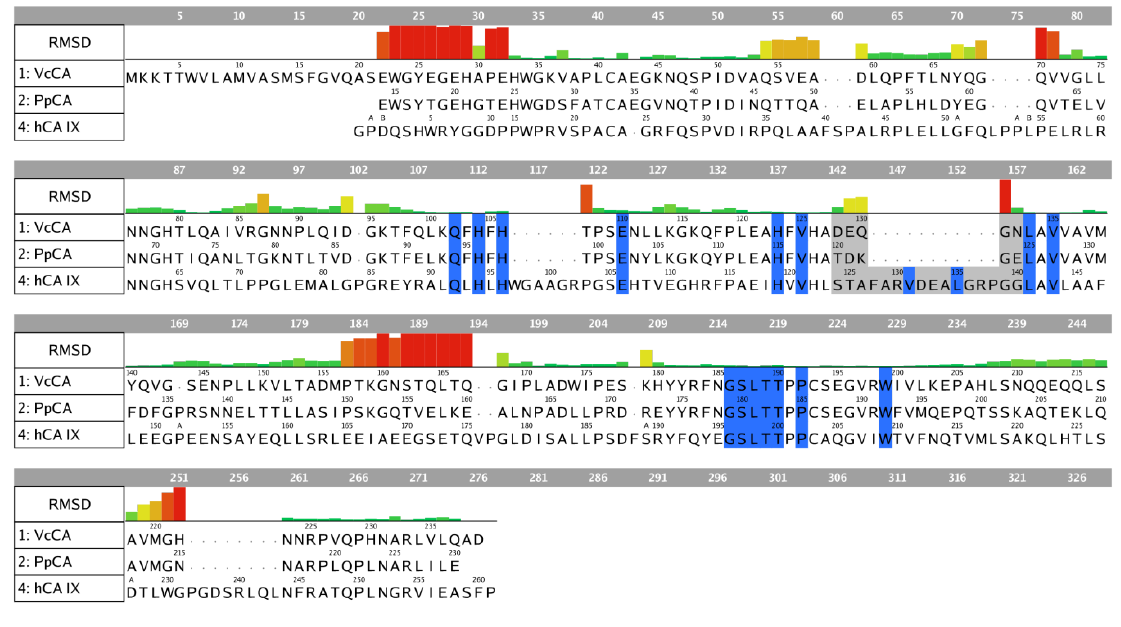
Figure 2. Sequence alignment of VcCA (UniProt: A0A0X1L2C8), PpCA (pdb: 5hpj) and hCA IX (pdb: 3iai). The residues indicated in blue belong to the binding pocket (within 4.5 Å of azm). The residues indicated in grey are part of the different folded loop near the pocket (Ser124 – Gly140; hCA IX numbering). The RMSD per residue between PpCA and hCA IX is shown.